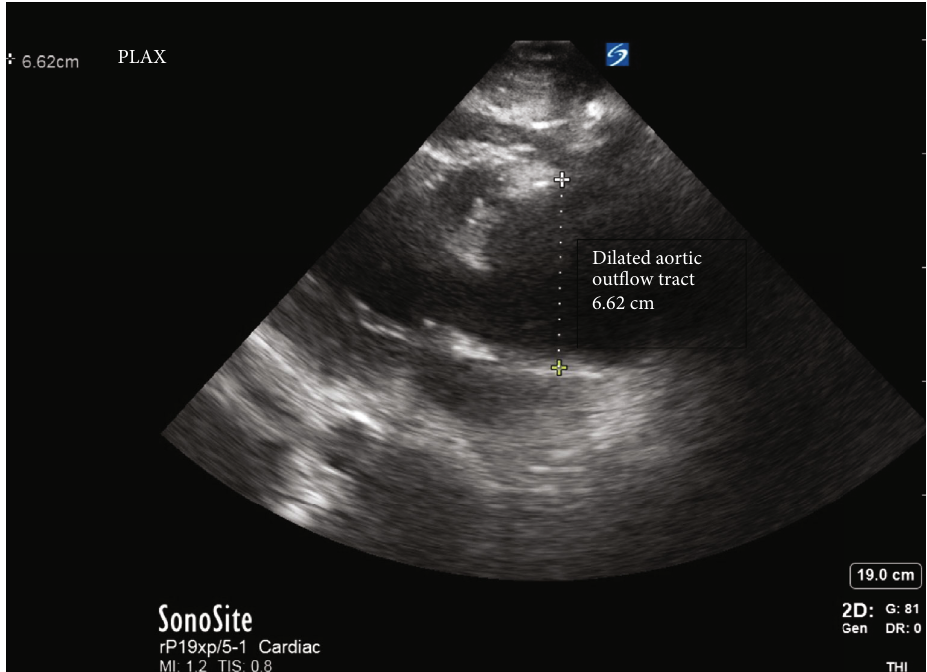
Figure 3: Parasternal long axis view of the heart, demonstrating a dilated aortic out fl ow tract measuring 6.62cm during diastole. Normal size of the aortic out fl ow tract is less than 4 cm.